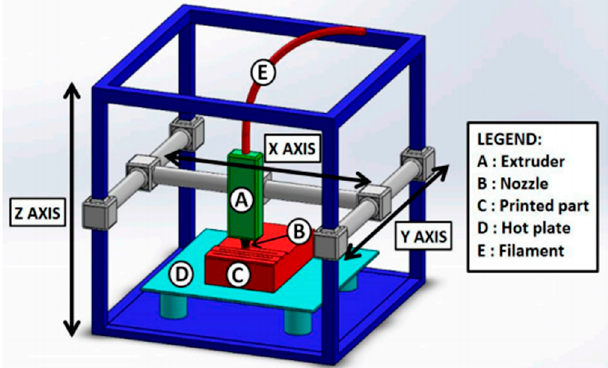
Figure 10. Typical fused deposition modelling (FDM) setup. (Reprinted with permission from [74]. Copyright Wiley Interscience,